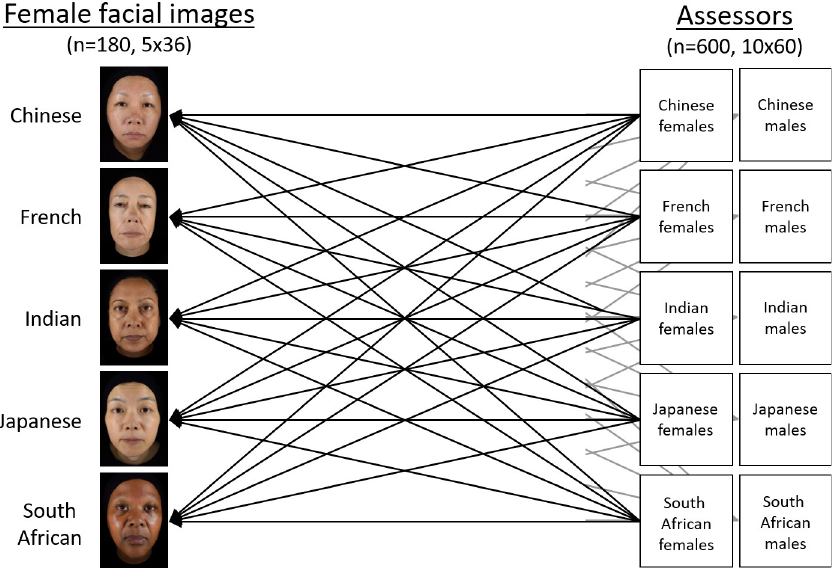
Fig 2. Experimental setup for the face rating. Na ï ve female and male assessors viewed facial images and provided spontaneous judgments of facial age, attractiveness, and health.